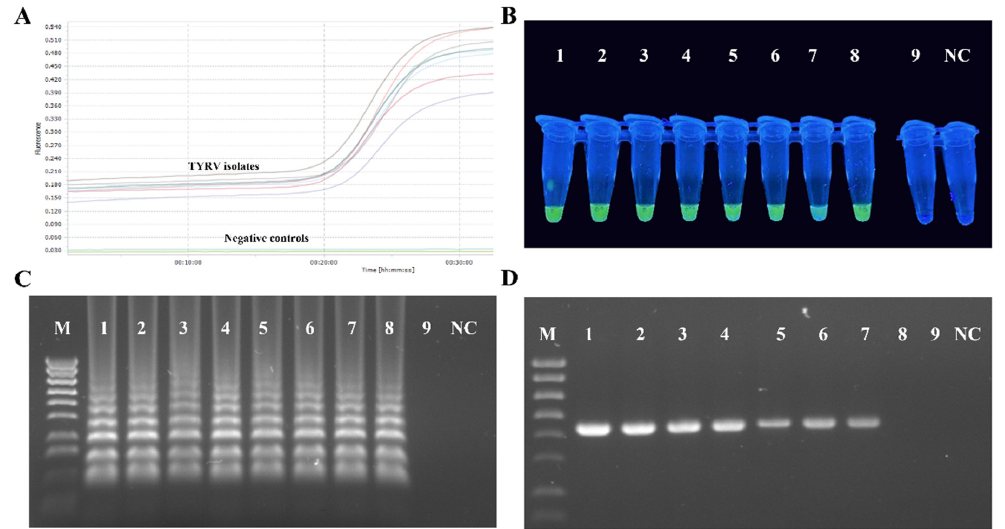
Figure 4. Results of RT-LAMP optimalization. ( A ) Amplification plots (showed with different colours) of eight tested TYRV samples monitored in the LightCycler ® 96 (Roche, Basel, Switzerland). Total RNAs isolated from healthy and TSWV-infected plants were used as negative controls. ( B ) Visual detection of RT-LAMP products using EvaGreen ® Dye (Biotium, Fremont, CA, USA) of eight TYRV isolates (TYRV-TK1, TYRV-TK2, TYRV-TK4, TYRV-BK1, TYRV-BK2, TYRV-H, TYRV-KOR1, TYRV- KOR2, probes 1–8, respectively), TSWV isolate (probe 9) and healthy plant (NC). ( C ) Electrophoretic separation of RT-LAMP products in a 2% agarose gel. M- Gene Ruler 1 Kb Plus Ladder (ThermoFisher Scientific, Watham, MA, USA), lines 1–9—ten-fold dilutions of total RNA of TYRV-H isolates, NC- negative control. ( D ) Electrophoretic separation of RT-PCR products in 1.5% agarose gel. M-Gene Ruler 1 Kb Plus Ladder (ThermoFisher Scientific, Watham, MA, USA), lines 1–9 ten-fold dilutions